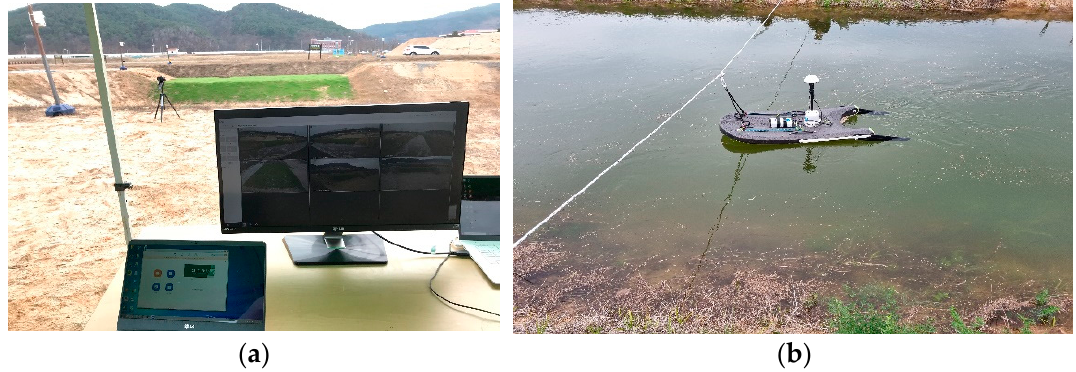
Figure 5. ( a ) Real-time image and ( b ) Acoustic Doppler Current Profiler (ADCP) measurement sys- tems.